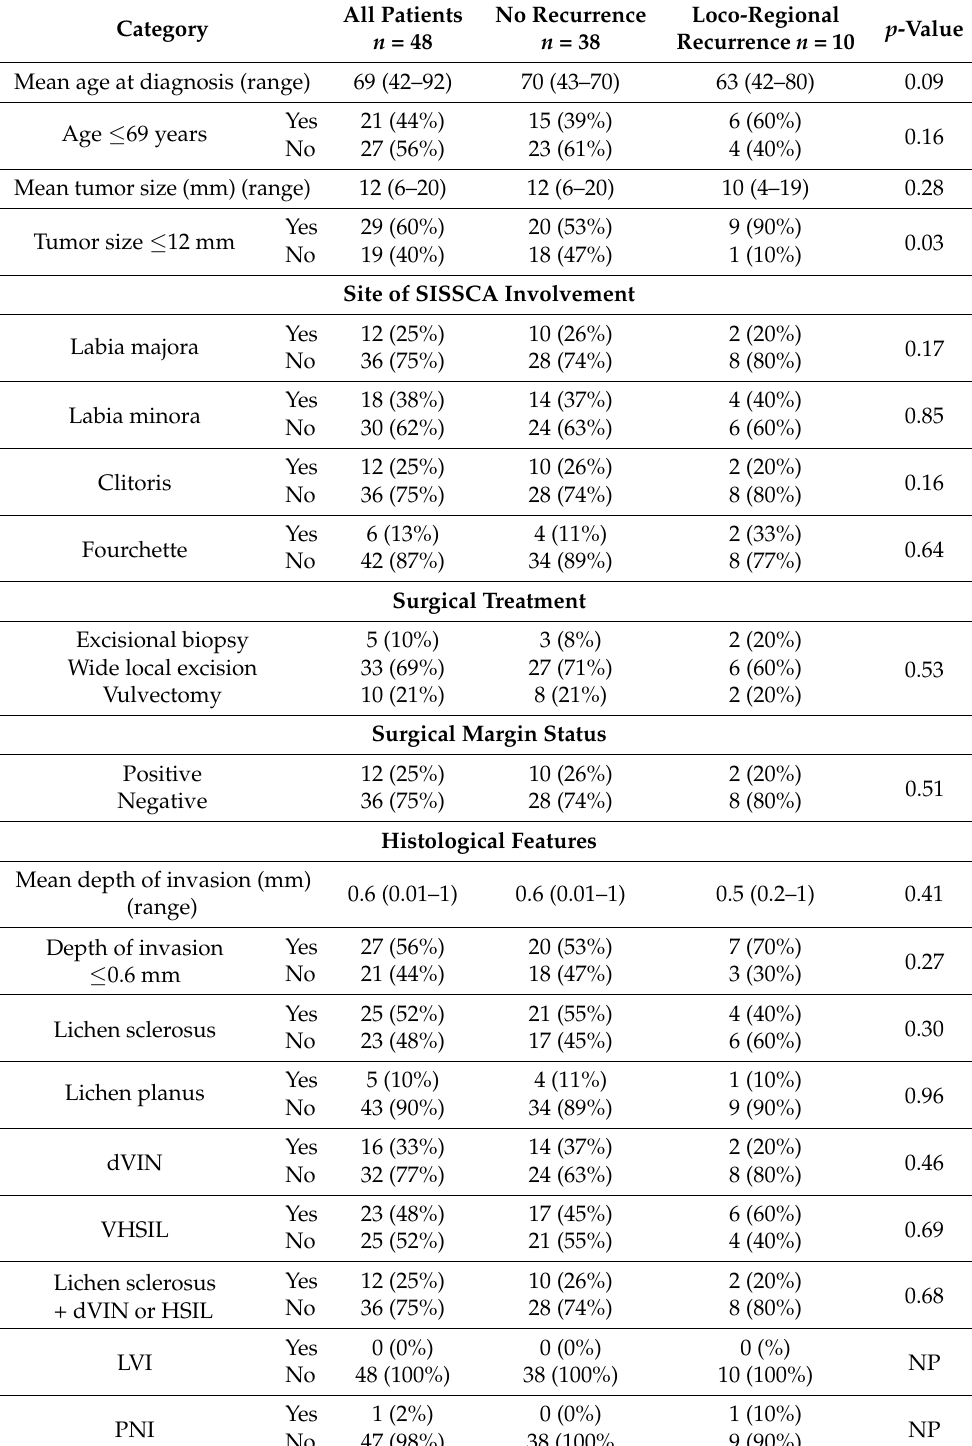
Table 1. Clinico-pathological characteristics of the analyzed SISCCA